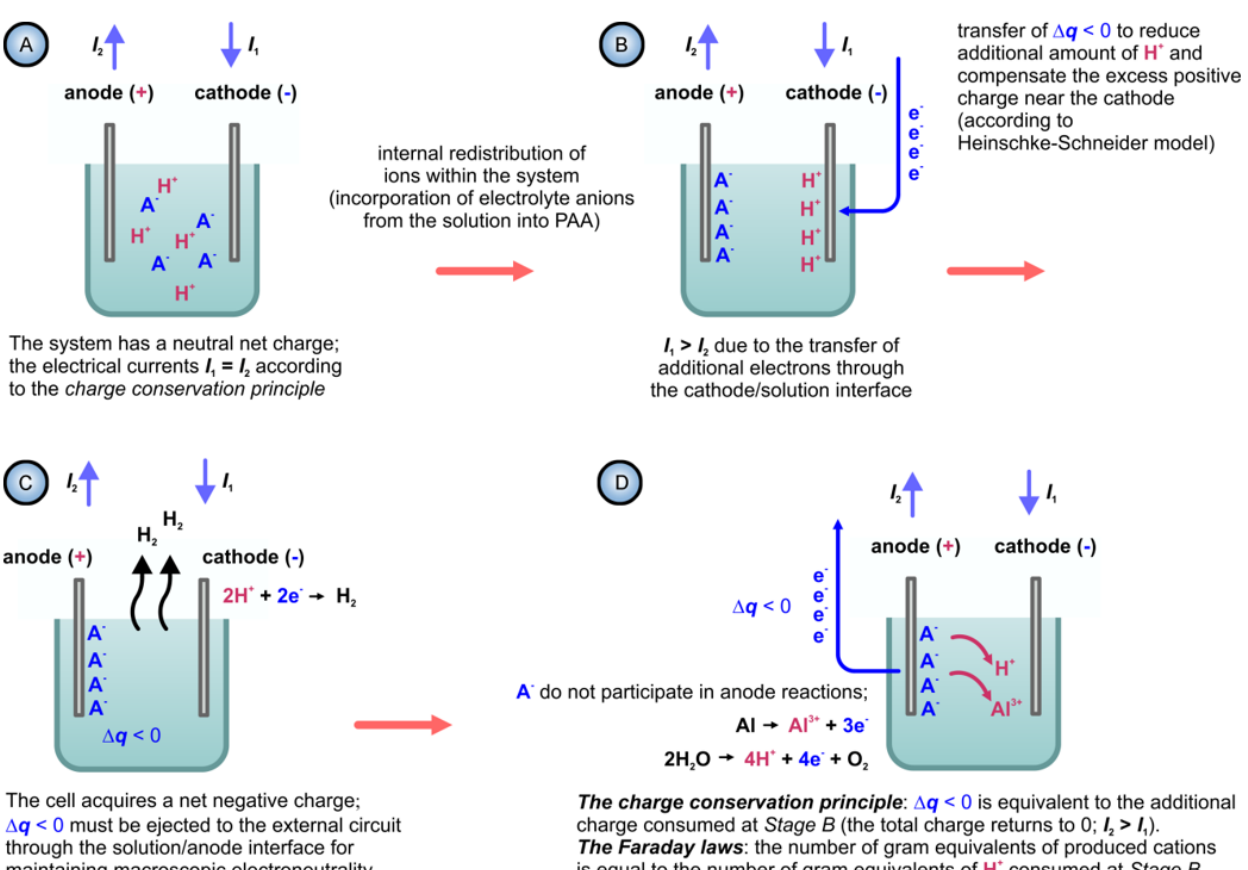
Figure 32. A set of the electrochemical processes that should occur in an anodizing cell ( A ) on the assumption that the incorporation of electrolyte anions into PAA leads to the reduction of an additional amount of H + at the cathode (the excess positive charge compensation mechanism suggested in the Heinschke–Schneider model; see stages ( B ) and ( C )). The supporting electrolyte is taken in this schematic diagram to be monovalent. It is evident that the complete sequence of all necessary redox reactions can only lead to the increase in Al 3+ concentration and in pH (see ( D )), but it cannot reduce the total positive charge carried by the different types of cations in the solution (if the process stops at stage ( C ), the electro-neutrality condition will be violated). Taking into account the macroscopic electro-neutrality of the entire system, the mechanism suggested by the authors of the mathematical model from Ref. [150] does not seem reasonable due to contradiction to the charge conservation principle and two Faraday laws (see ( D )).